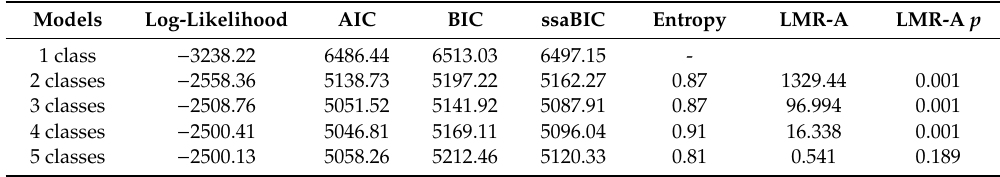
Table 1. Fit indices for the latent class models on suicidal behavior for the total sample.